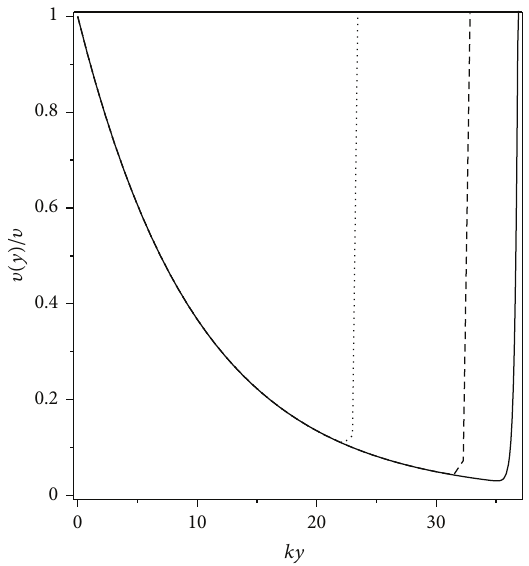
Figure 5: The VEV profile for negative induced brane cosmological constantwithpositivebranetensionfor ℵ = 33 (dottedline), ℵ = 34 = 100 . The (dashed line), and ℵ = ∞ (solid line, i.e., RS case) in the (𝑁, 𝑁) case 0 ̃𝜆 = 100 , ̃𝜆 = 100 . The values of other parameters of the model for 0 𝐿 are the same as the ones in Figure